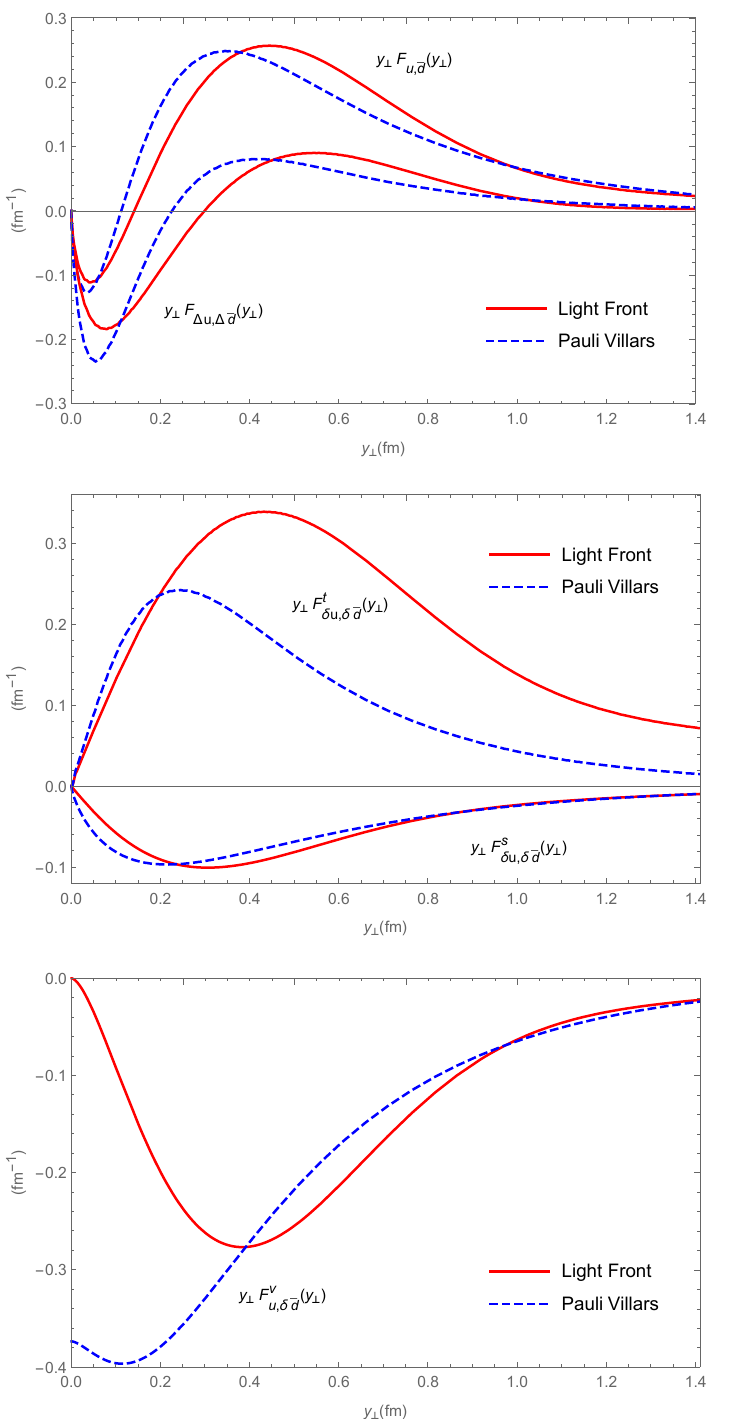
Figure 3 . As in (cid:12)gure 2, but in transverse coordinate space.